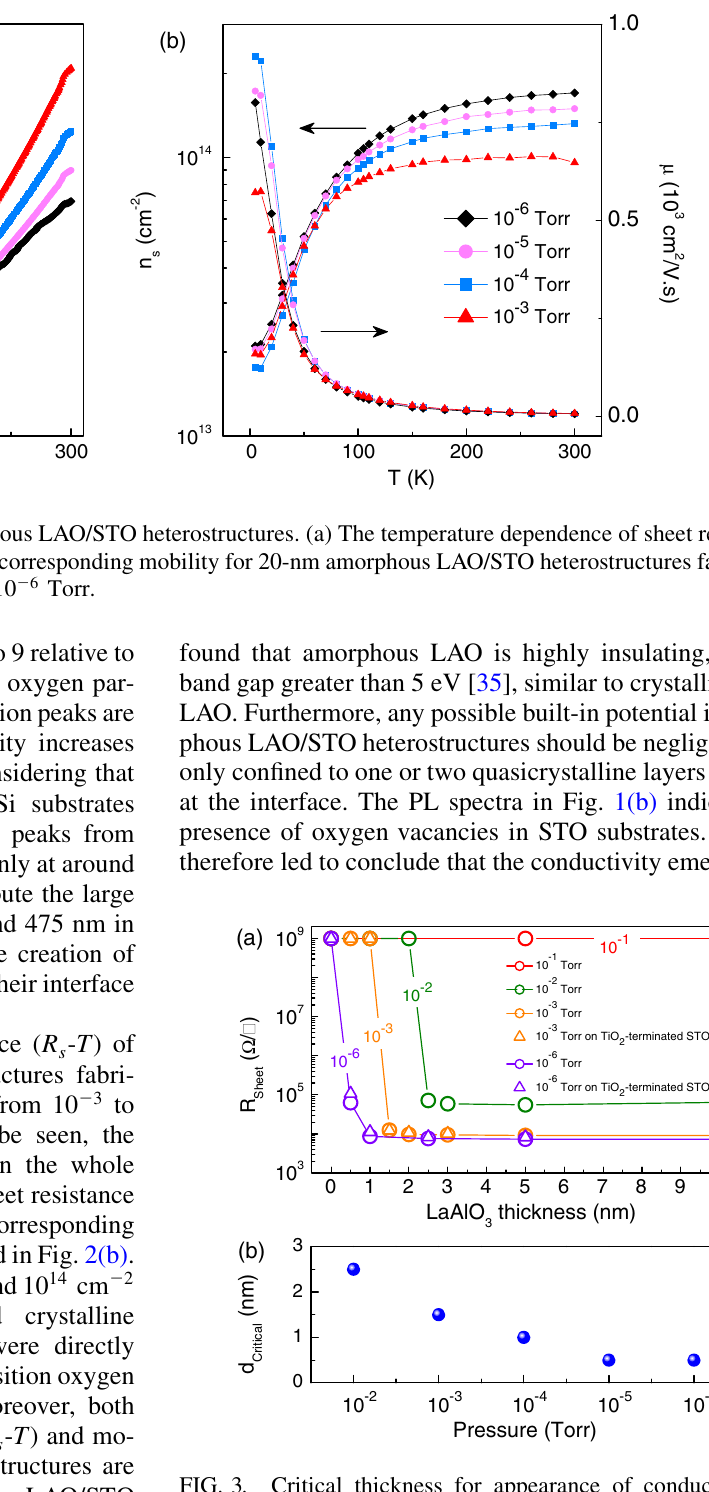
FIG. 3. Critical thickness for appearance of conductivity in amorphous LAO/STO heterostructures. (a) Thickness depen- dence of room-temperature sheet resistance of amorphous LAO/STO heterostructures prepared at different oxygen pres- sures and on different STO substrates. Triangle symbols repre- sent TiO 2 -terminated STO substrates, while circles represent untreated STO substrates. (b) Critical thickness as a function of deposition oxygen